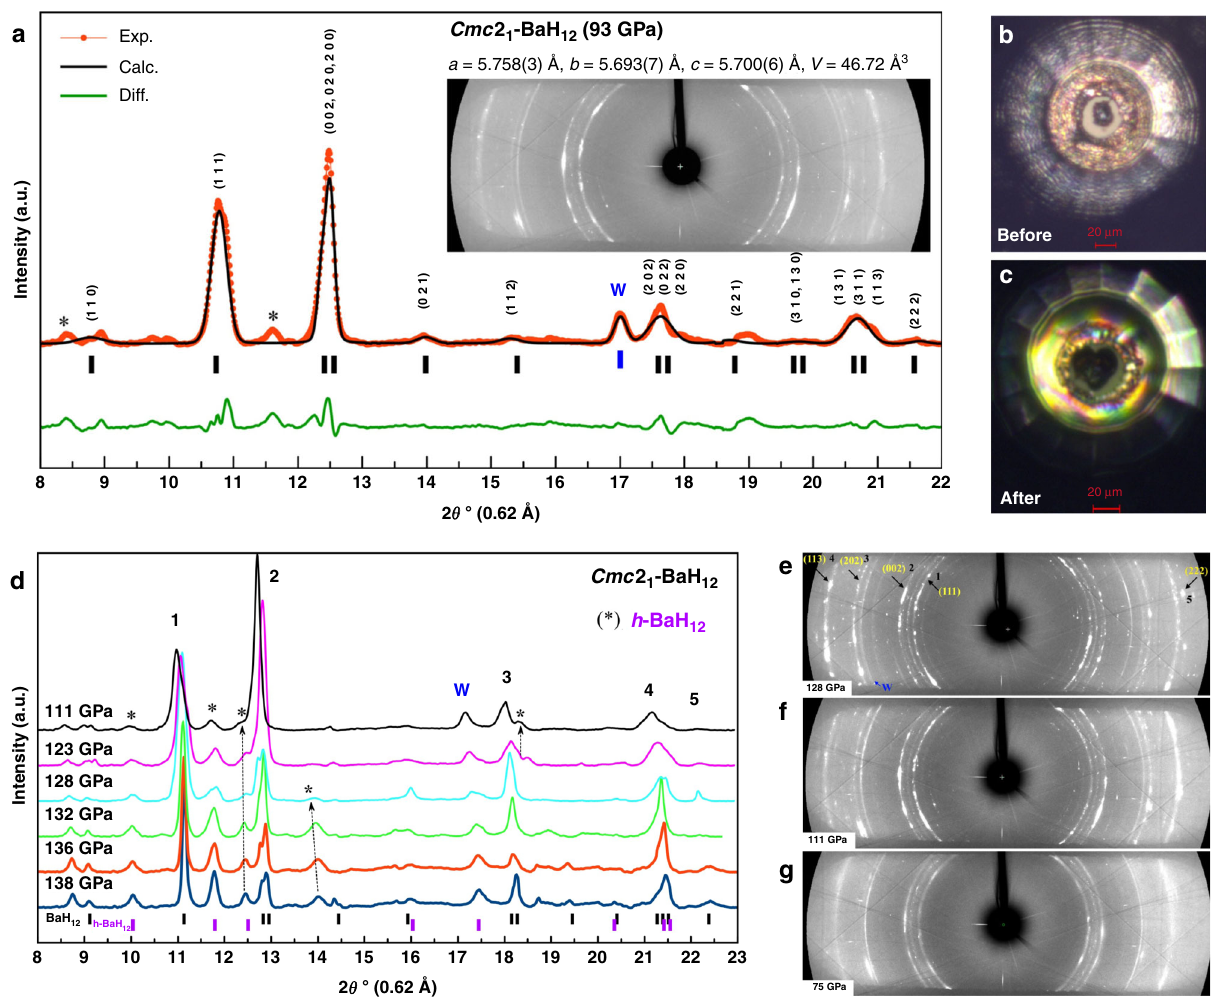
Fig. 3 Analysis of experimental XRD patterns of Cmc 2 1 -BaH 12 synthesized in DAC #B2. a Le Bail re fi nement of pseudocubic Cmc 2 1 -BaH 12 and bcc -W at 93 GPa. The experimental data, fi tted line, and residues are shown in red, black, and green, respectively. Inset shows the 2D diffraction image. Weak re fl ections, indicated by asterisks, may correspond to the impurity: possibly P 6 3 /mmc or P 6 3 mc -BaH 12 . b , c Microphotographs of the culet of cell #B2 with the Ba/AB sample before and after the laser heating. d Experimental XRD patterns from cell #B2 at pressures decreasing from 138 to 111GPa. e , f , g Powder X-ray diffraction images at 128, 111, and 75GPa. Re fl ections corresponding to the crystallographic planes in the ideal Fm (cid:1) 3 m -BaH 12 phase are indicated by